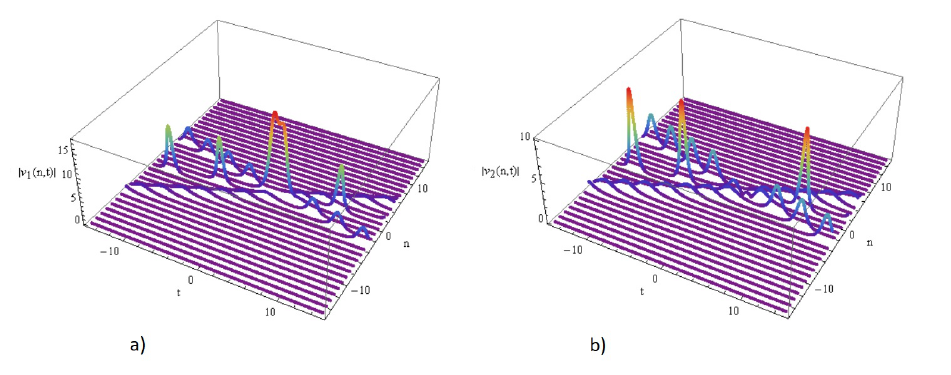
Figure 2. Plots of | v 1 ( n , m ) | = | G 1 / F 1 | (a) and | v 2 ( n , m ) | = | G 2 / F 2 | (b) given in (8), the absolute values of the 3-ss for the focusing semidiscrete cmKdV with two coupled equations (4), for the chosen parameters k 1 = 1 , k 2 = 2 , k 3 = 3 ,ϵ 1 = − 1 ,ϵ 2 = 1 ,ϵ 3 = − 1 and suitable intervals for n and t